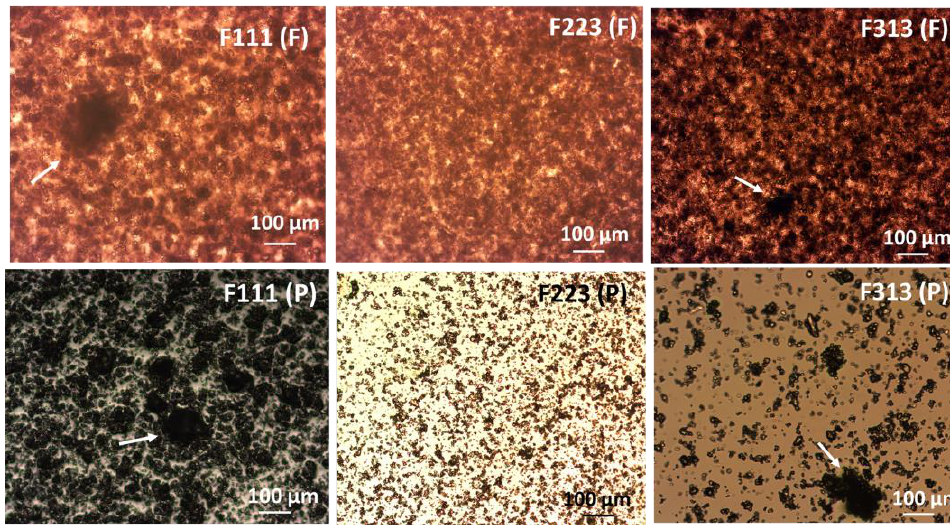
Figure 5. Optical microscopy images of dried-films ( F ) and precursor suspensions ( P ) processed at different mixing conditions, the first row from left to right; F111 ( F ), F223 (F), F332 ( F ), and second row from left to right; F111 ( P ), F223 ( P ), F332 ( P ).